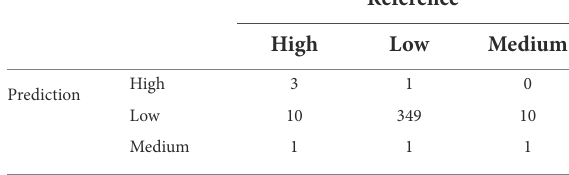
TABLE 1 Confusion matrix of multinomial outcome class for AFL-GBM analysis to validate reference (testing data set) actual data for toxin levels and the predicted results using the